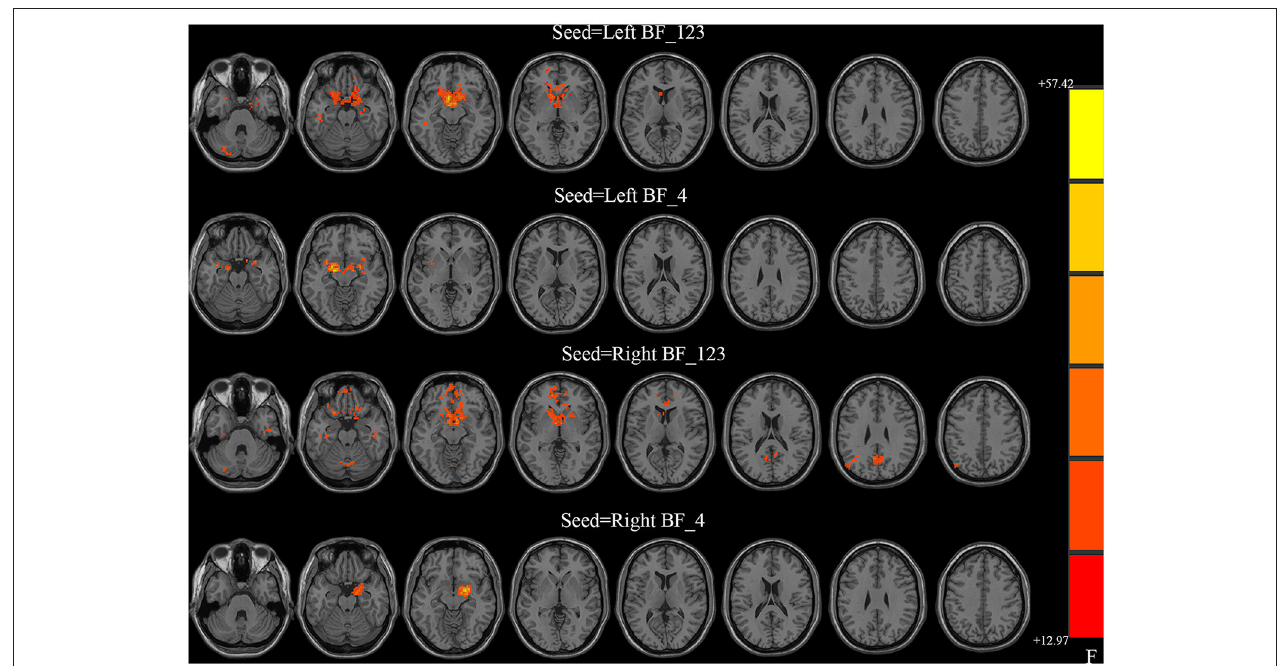
FIGURE 1 | Between-group differences in the resting-state functional connectivity (RSFC) with all four basal forebrain subregions in groups with temporal lobe epilepsy (TLE). The colored bars indicate the P values. SPM software was used to map the data onto the brain’s